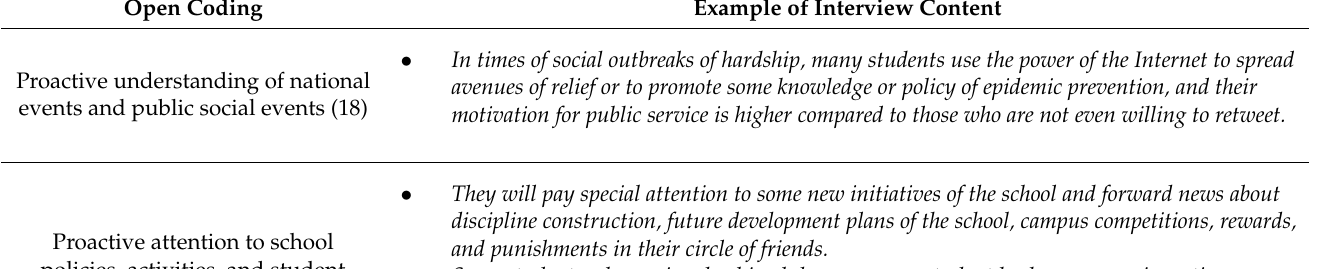
Table 2. Material information of the sub-node “Attraction to policy making” of axial coding. Open